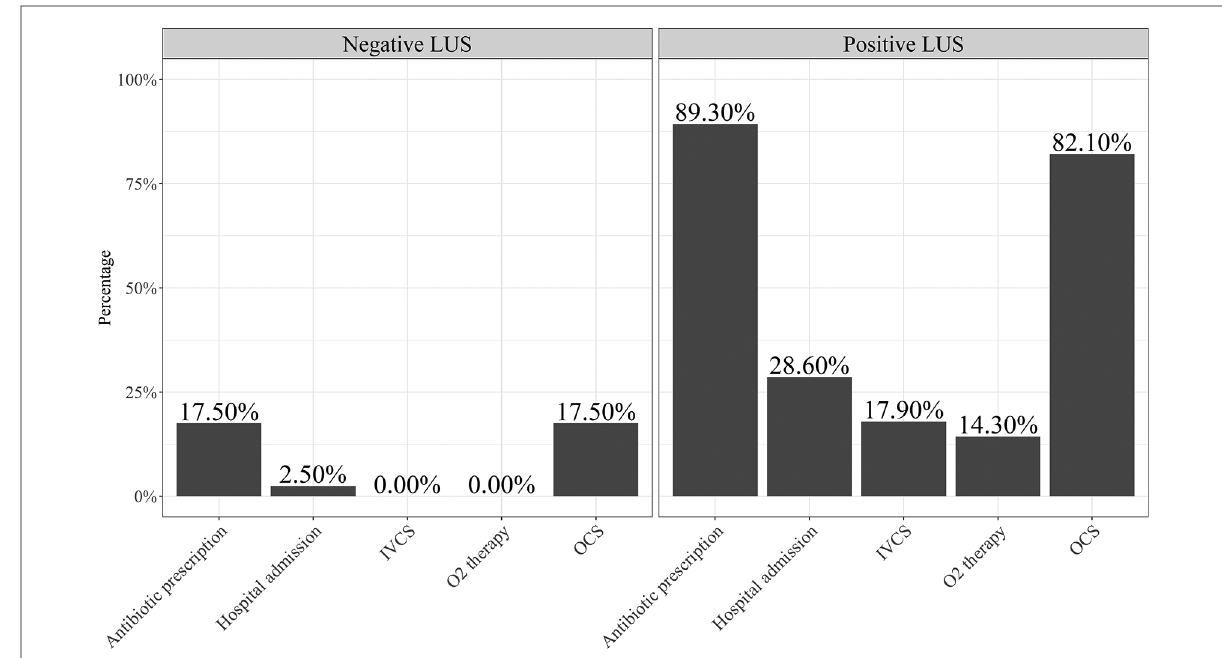
FIGURE 2 Description of the clinical diagnosis of patients with wheezing. LUS, lung ultrasound.